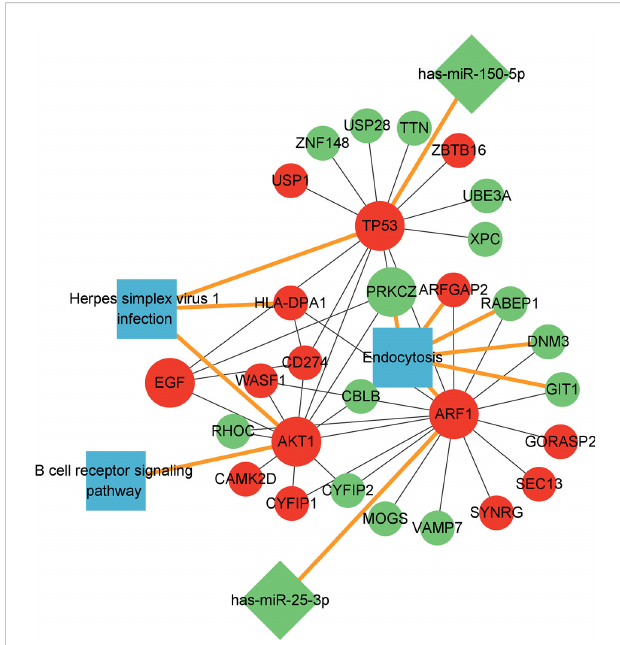
FIGURE 7 miRNA-mRNA-pathway regulatory network diagram.Red: up- regulated expression genes; Green: down-regulated expression genes; Blue: related pathways; Round: mRNA, the larger circle represents the 6 key mRNAs, the diamond represents the miRNA, and the square represents the related pathway. mRNA-miRNA and mRNA-pathway was emphasized with yellow